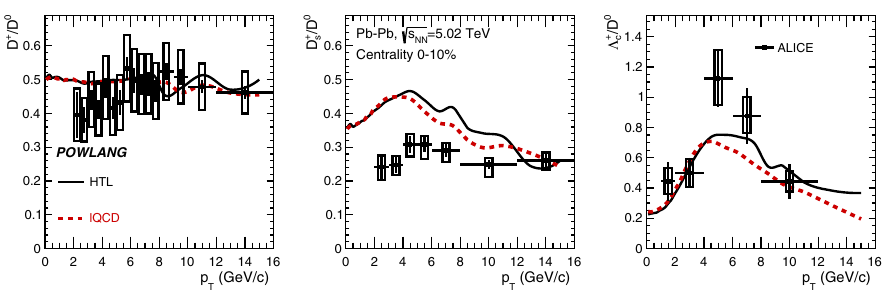
Figure 1. Left panel: the invariant-mass distribution of the Qq and Q ( qq ) clusters at the hadronization Figure 2. Predictions for the relative yields of charmed hadrons (relative to D 0 mesons) in central hypersurface in the di ff erent isospin, strangeness and spin channels. Right panel: cluster invariant-mass Pb-Pb collisions at √ s NN = 5 . 02 TeV for di ff erent transport coe ffi cients compared to recent ALICE distributions in case recombination occurs locally (continuous curves, default implementation), with data [5, 7, 8]. strong correlation between the parton momenta and position, or non-locally (dashed curves), with no space-momentum correlation. All results refer to central Pb-Pb collisions at √ s NN = 5 . 02 TeV, with charm quark propagation before hadronization described by HTL transport coe ffi cients.